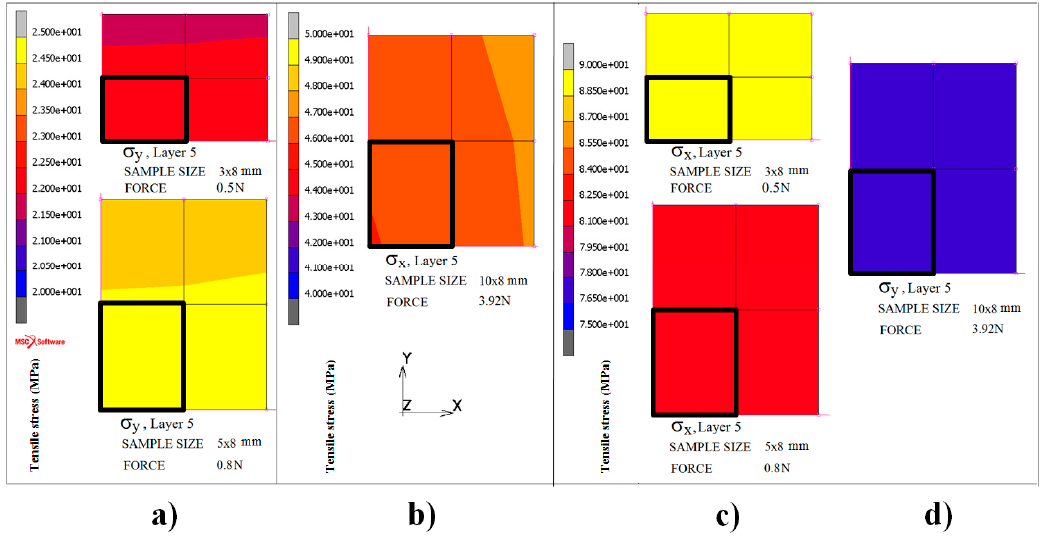
Figure 6. Homogeneous distribution of σ x ( b , c ) and σ y ( a , d ) tensile stresses in the area of one element (denoted by black rectangle) on the sample surface.